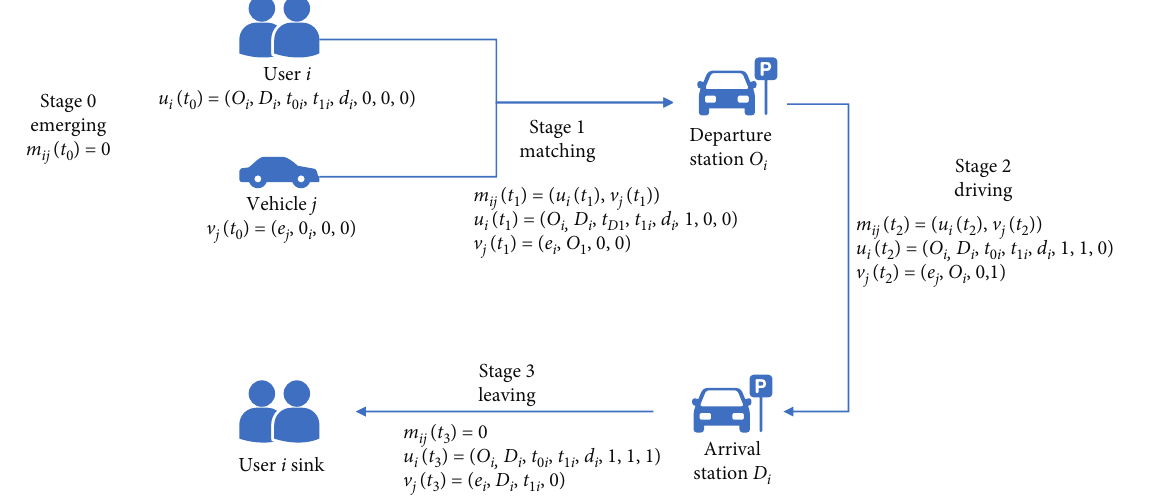
Figure 1: Interaction between user agent and vehicle